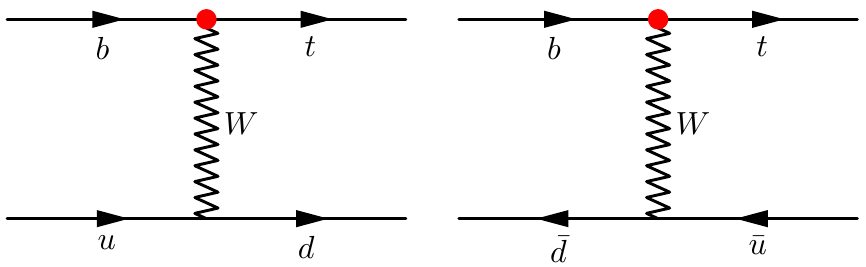
Fig. 1 Feynman diagrams for t -channel single top production at LO. An incoming bottom quark and either an incoming up type (left) or anti-down type (right) quark exchange a virtual W boson, a so-called